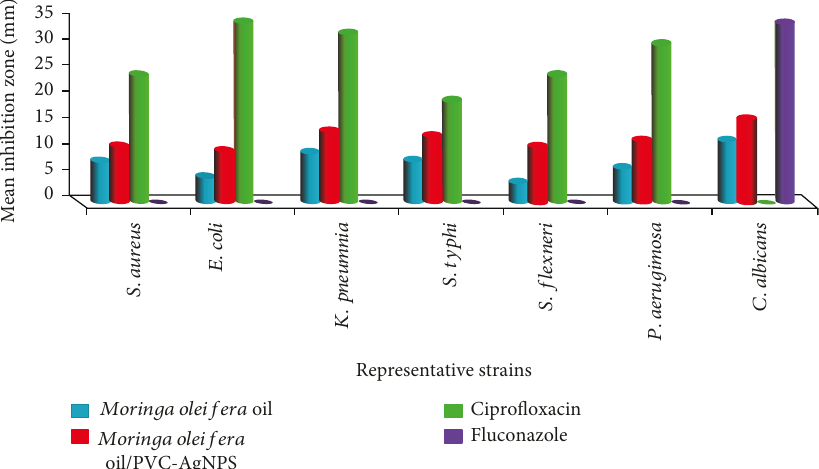
Figure 8: Comparison of the antibacterial activity of Moringa oleifera seed oil and Moringa oleifera oil/PVC-AgNP bionanocomposites against representative strains.